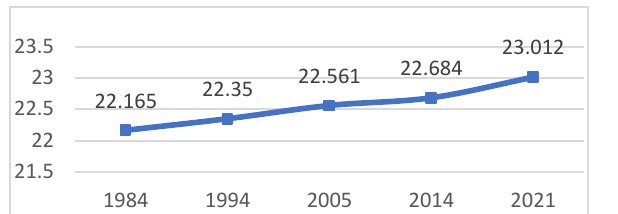
Figure 6. Temperature changes in the studied area in degrees Celsius.